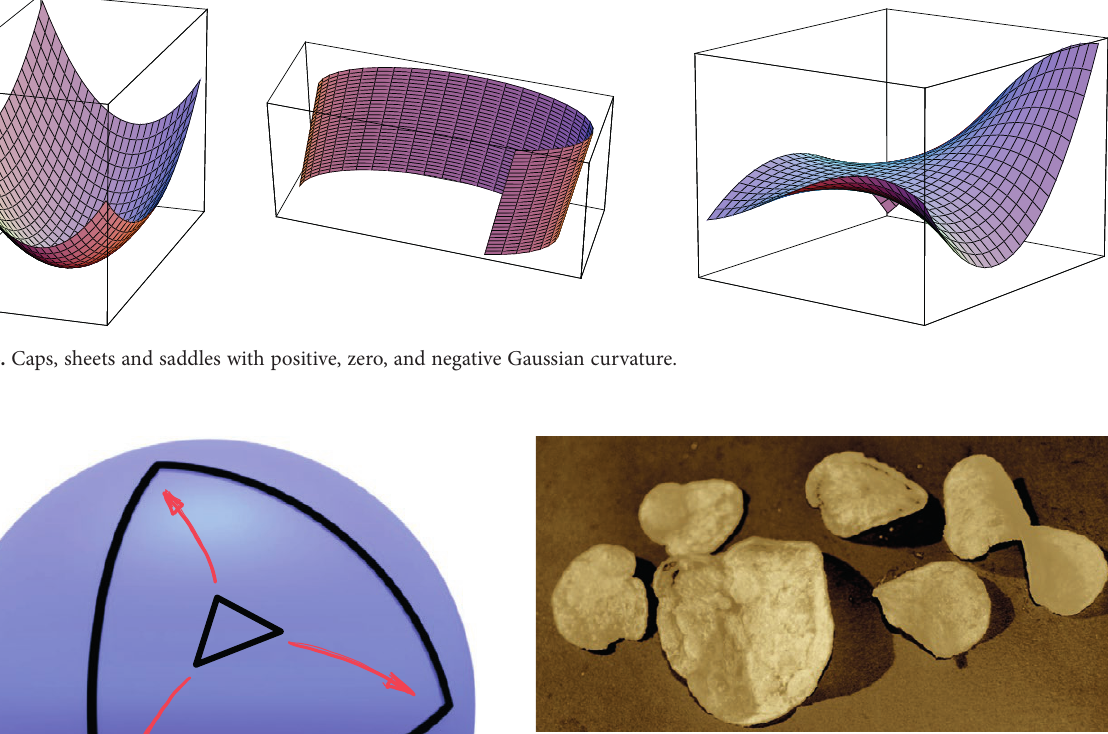
Figure 16. Th e variety of surface form in potato